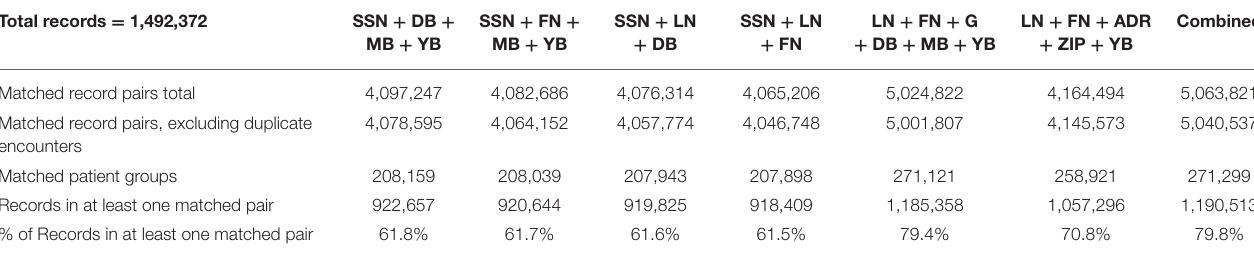
TABLE 4 | Deterministic patient matching